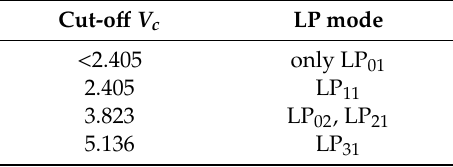
Table 1. Several lowest order linear polarization (LP) modes and their corresponding cut-o ff frequency V c